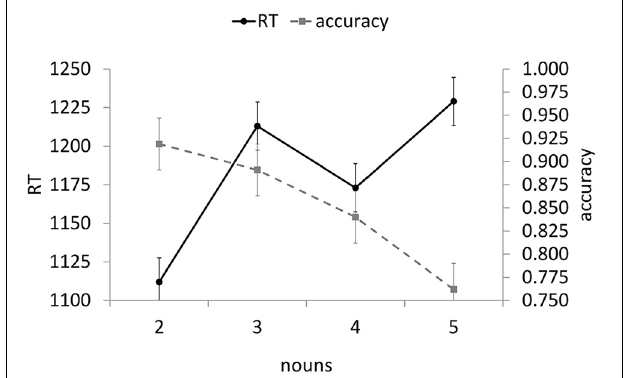
FIGURE 2 | Experiment 1B distractor probe reactions times and accuracies by noun condition (error bars indicate SE of the